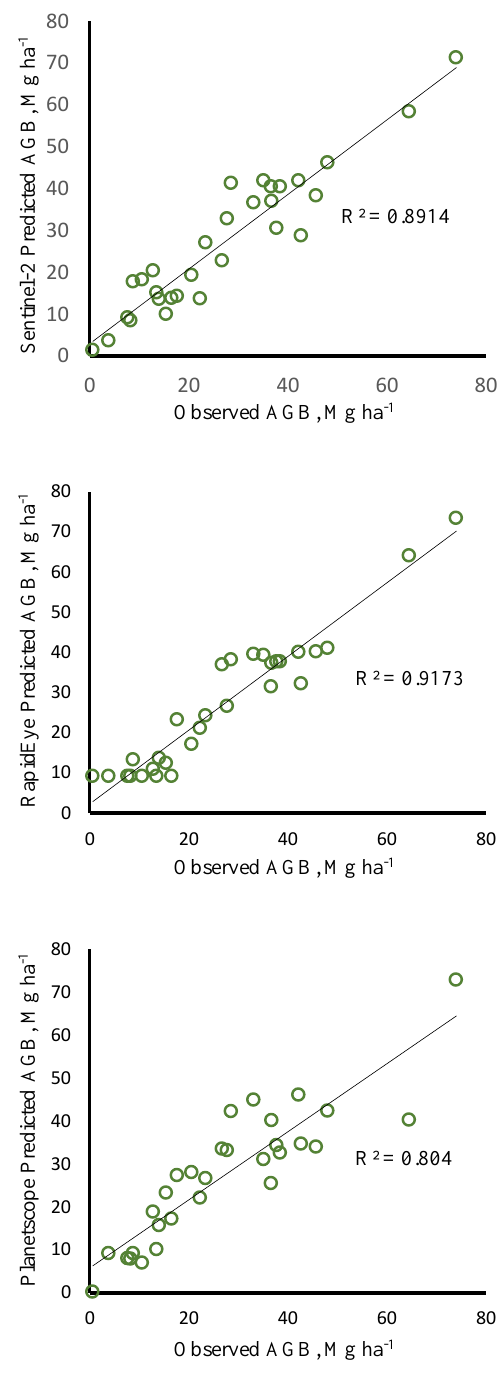
Figure 3. Best MARS regression models showing relationship of observed and predicted AGB from Sentinel (top), RapidEye (middle) and PlanetScope